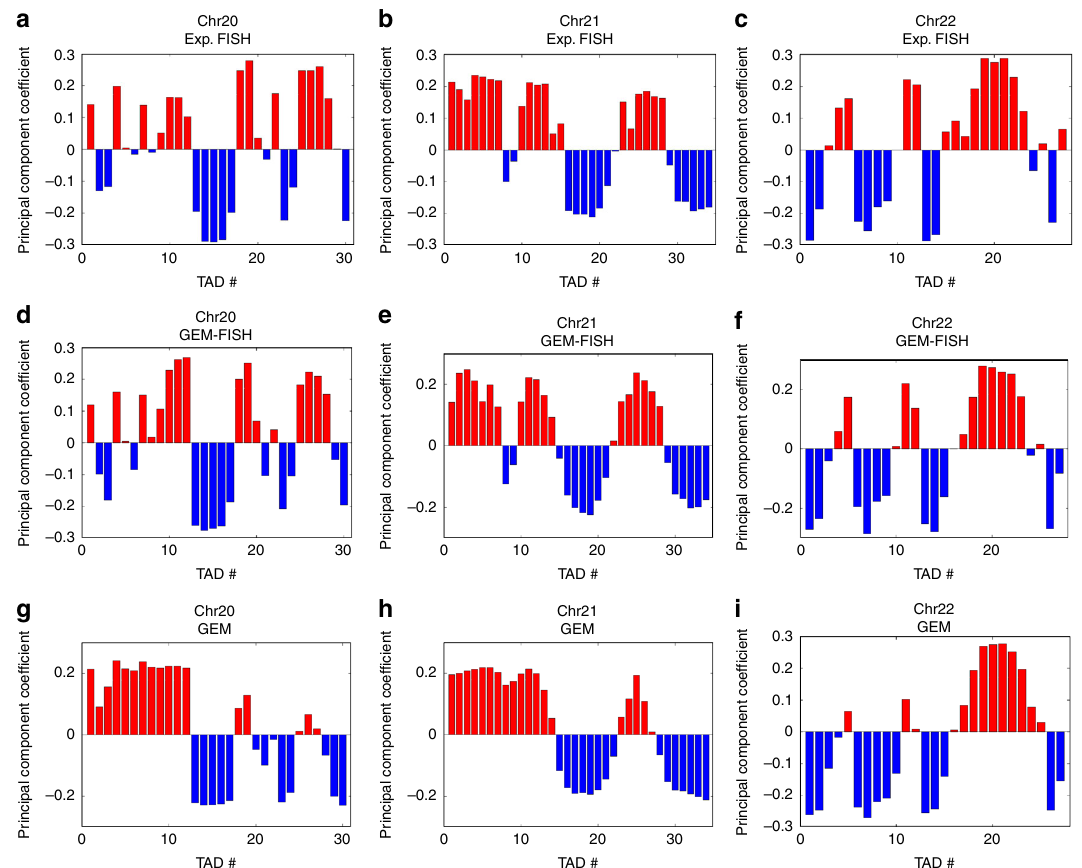
Fig. 3 Assignment of TADs to A/B compartments for Chrs 20, 21, and 22. a – c Assignment of TADs for Chrs 20 ( a ), 21 ( b ), and 22 ( c ) using the experimental FISH data (obtained from ref. 9 ). d – f Assignment of TADs of the 3D chromosome models calculated by GEM-FISH using both Hi-C and FISH data for Chrs 20 ( d ), 21 ( e ), and 22 ( f ). g – i Assignment of TADs of the 3D chromosome models calculated by GEM using only Hi-C data for Chrs 20 ( g ), 21 ( h ), and 22 ( i